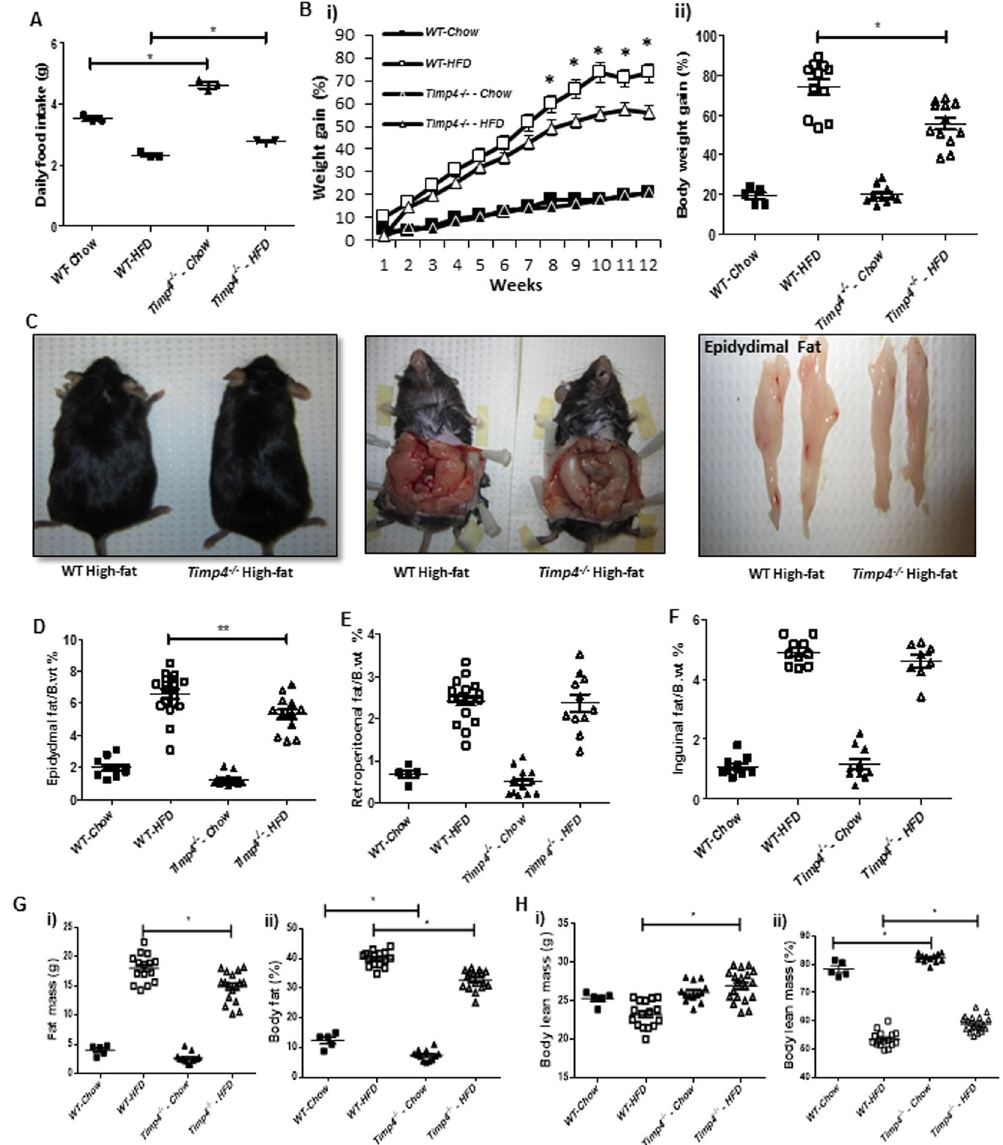
Figure 2. Timp4 − / − mice exhibit increased food intake but reduced body fat percentage. Weekly food intake ( A ), rate of weekly body weight gain ( Bi ) and percent weight gain ( Bii ) in WT and T imp4 − / − mice following chow or high fat diet (HFD). ( C ) Dorsal and ventral view, and macroscopic images of epididymal fat pads from high fat-fed WT and Timp4 − / − mice. ( D – F ) Epidydimal fat, retroperitoneal fat and inguinal fat as percentage of body weight in indicated groups. ( G – H ) Whole body fat content (absolute, Gi; as percentage of body weight, Gii ), and lean body mass (absolute, Hi ; and as percentage of body weight, Hii ) assessed by Echo-MRI body mass composition analysis. Significance between the chow-fed and HFD-fed groups within the genotypes are not shown in the figure. Averaged data are presented as mean ± S.E.M and analyzed by ANOVA. * p < 0.05 for the indicated